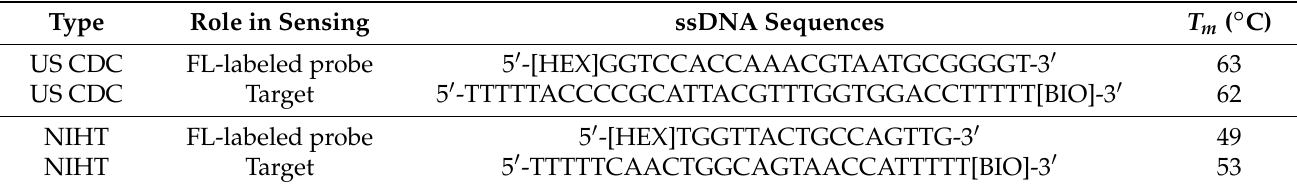
Table 1. FL-labeled ssDNA modeling a partial N-gene RNA of SARS-CoV-2 and the complementary probe (type: US CDC) [1]; the GC (%) is 41.2 and 58.3%, respectively. Another set is also shown (type: NIHT) [1]; the the GC (%) of the target and probe is 30.8 and 50.3%, respectively. Symbols [HEX] and [BIO] denote FL-label HEX and biotin, respectively. T m is melting temperature, evaluated using Equation